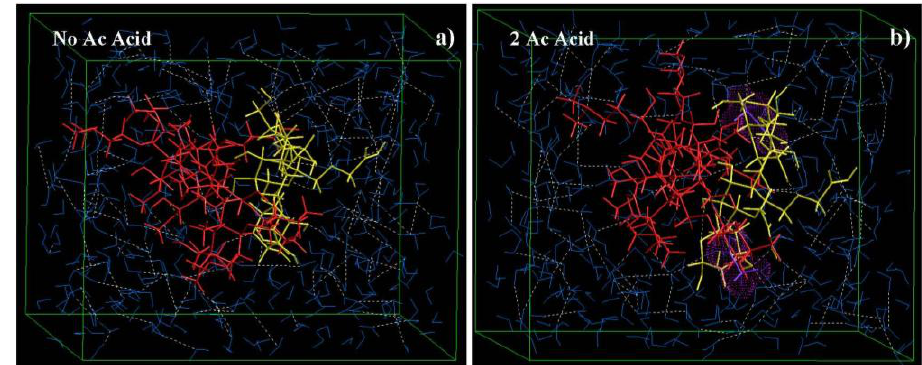
Figure 10. Visualization of geometrical preferences of IPEC molecule presence of ( a ) no acetic acid molecules; ( b ) 2 acetic acid molecules; ( c ) 4 acetic acid molecules; and ( d ) 8 acetic acid molecules after molecular simulation in a solvated system consisting of water molecules. Color codes for molecules: NaCMC (yellow), E100 (red), Acetic acid (purple), and water